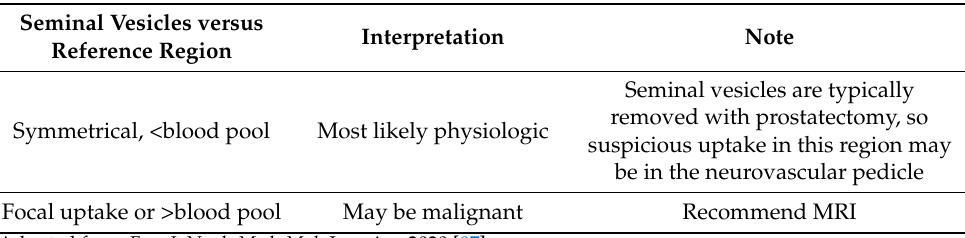
Table 4. Seminal vesicles. Interpretive criteria for 18 F fluciclovine (Axumin ® ) for the seminal vesicles in patients with prostate cancer *.